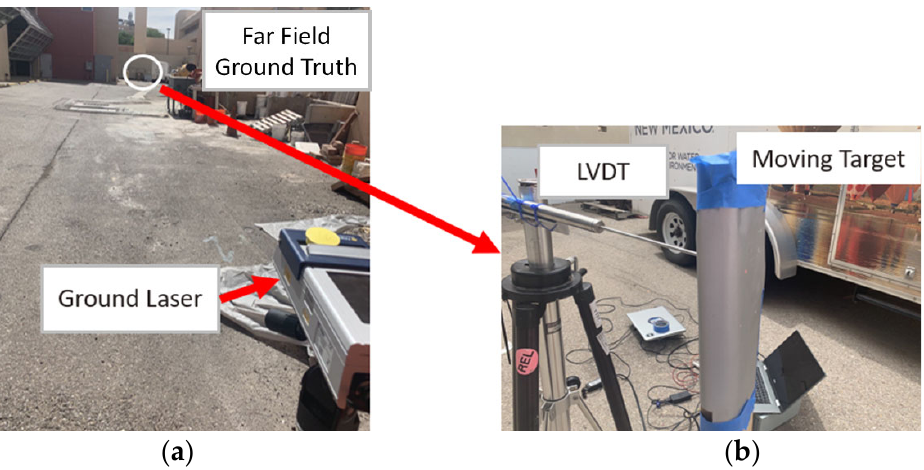
Figure 3. Validation ground laser: ( a ) RSV-150 remote sensing Polytec vibrometer (ground laser) at 55 m; ( b ) Detailed view of the far field ground truth collection with LVDT from moving target.